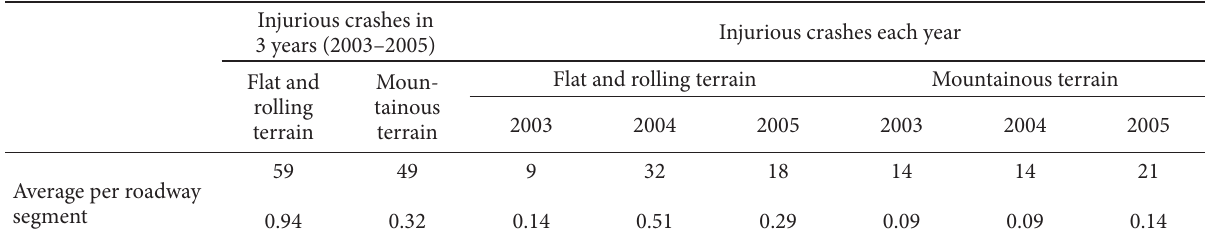
Table 3. Descriptive statistics of the analyzed crash